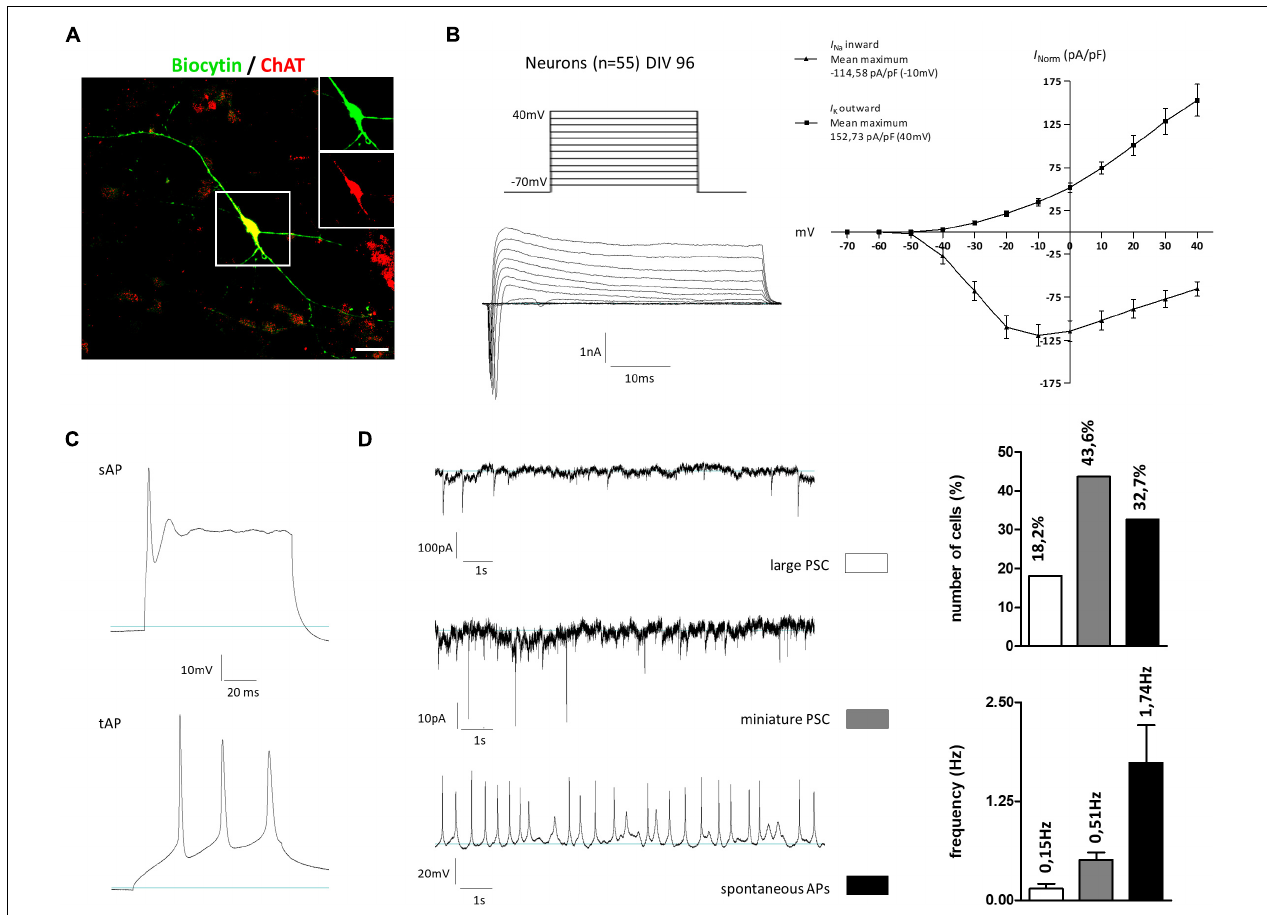
FIGURE 8 | Electrophysiological properties of hiPSC-derived cholinergic neurons 96 days after the onset of differentiation. (A) Representative image of a large multipolar neuron ( n = 55) that was selected for patch-clamp studies. For later immunotype characterization some of the recorded cells were marked via biocytin and subsequent streptavidin staining. Insets show biocytin (green) and ChAT (red) staining in the perinuclear region. Scale bar: 20 µ m. (B) Depolarizing steps in stepwise increments of 10 mV from a holding potential of –70 to +40 mV were performed in the whole-cell voltage-clamp mode to trigger voltage-dependent sodium and potassium currents. (C) Evoked action potentials (AP) were recorded as single APs (sAP) but also as train APs (tAP) typically observed in mature neurons. (D) Spontaneous activity was observed in the whole-cell recording mode by means of large AP-dependent postsynaptic currents (large PSC; upper figure) in 18.2% of the cells with a frequency of 0.15 ± 0.06 Hz. As a result of spontaneous vesicle release, miniature PSCs were recorded in 43.6% of all recorded cells with a frequency of 0.51 ± 0.09 Hz. Current-clamp recordings further revealed the firing of spontaneous APs in 32.7% of the cells with a frequency of 1.74 ± 0.48 Hz. All values are presented as means ±